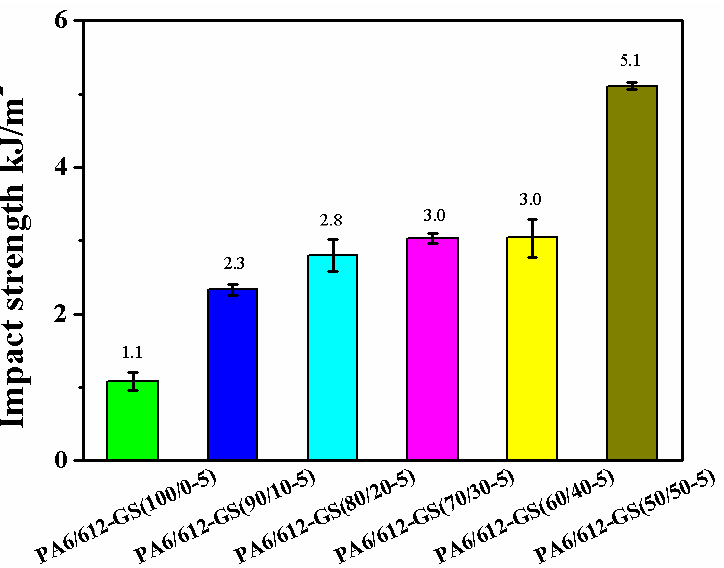
Figure 9. Impact strength of PA6/612-GS composites: average values of resistance to impact, obtained